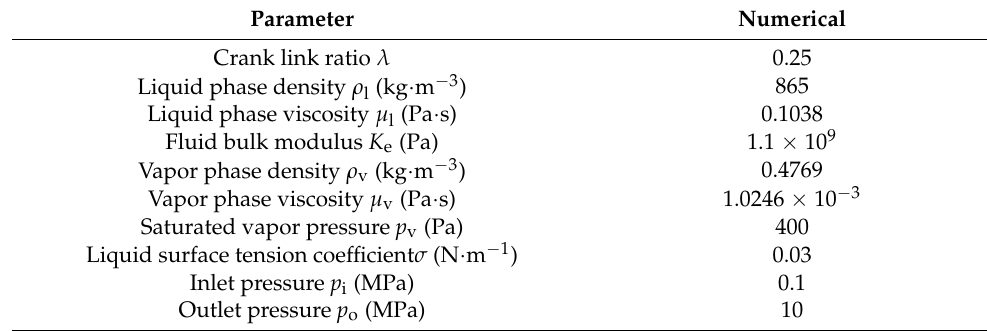
Table 1. Simulation parameters.